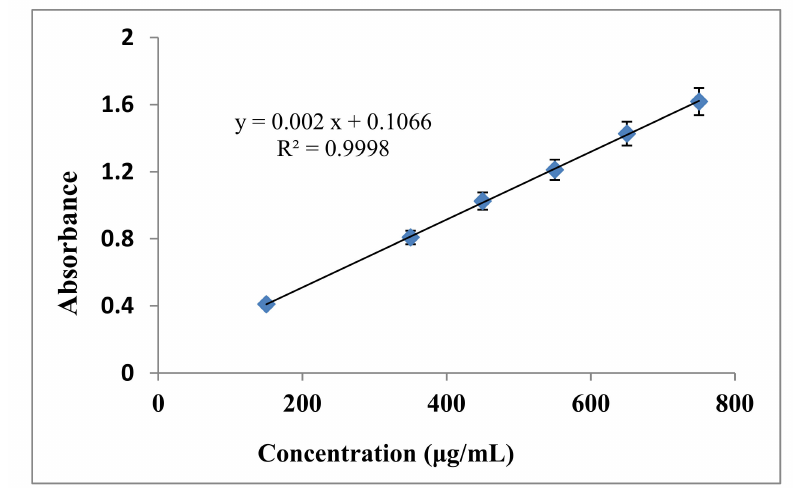
Figure 1. Gallic acid standard calibration